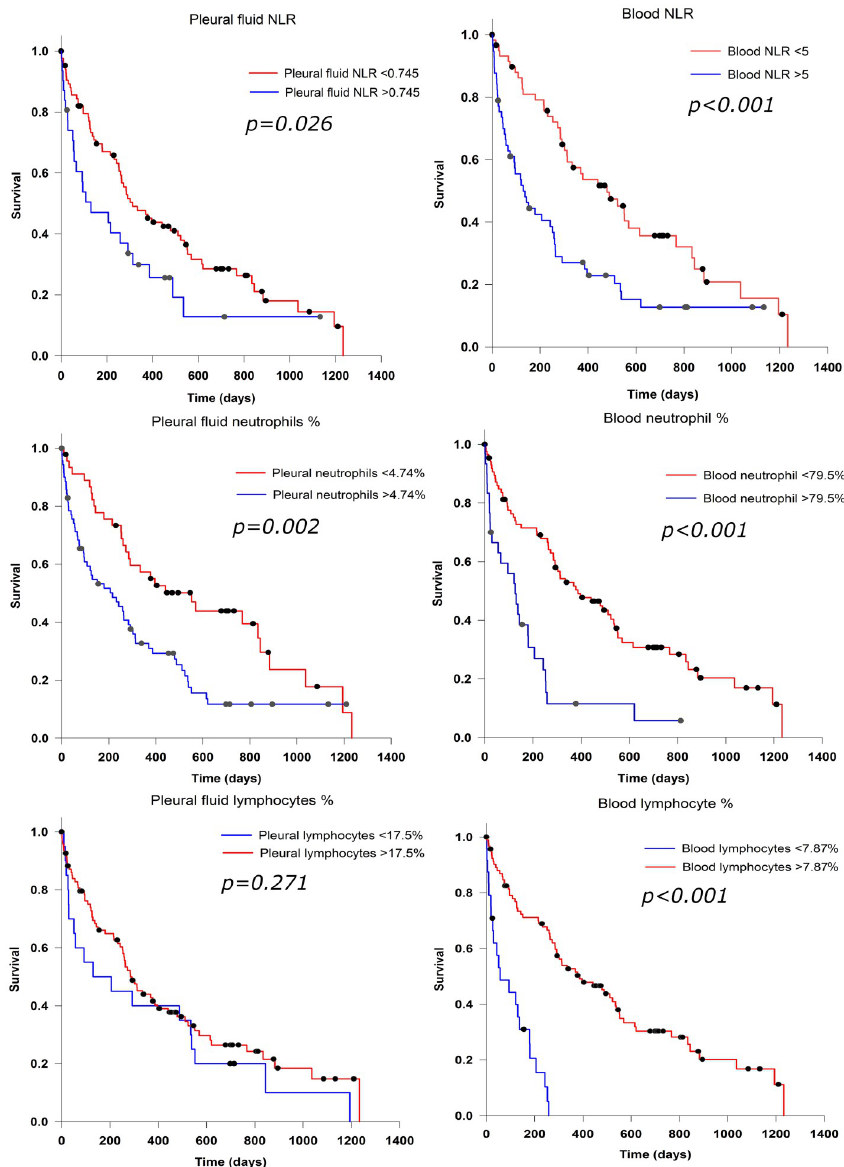
Fig 4. Survival analysis in patients with